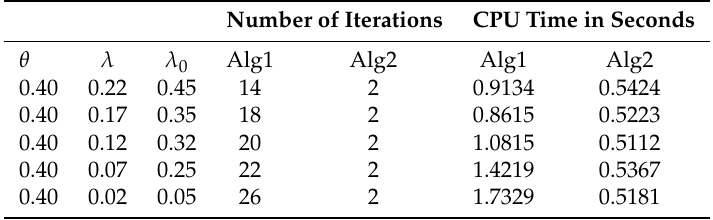
Table 1. Example 1: Algorithm 1’s (Alg2) numerical comparison with Algorithm 1 in [19]. Number of Iterations CPU Time in